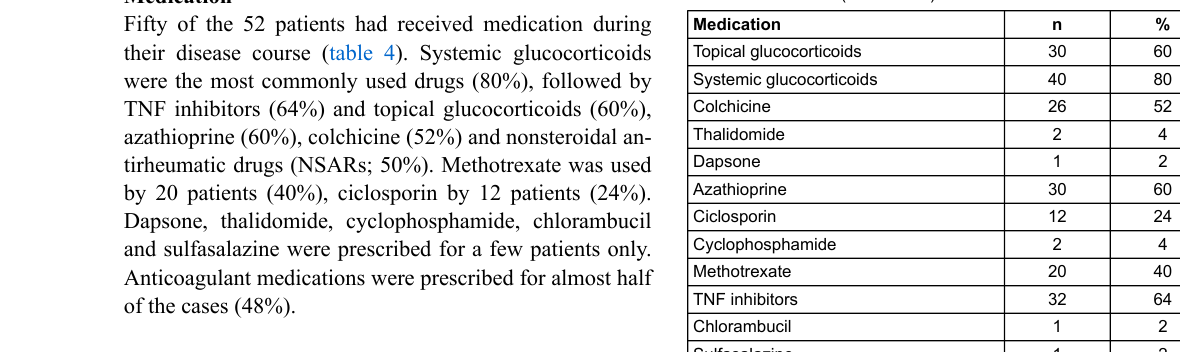
Table 4: Medication (total n = 50).